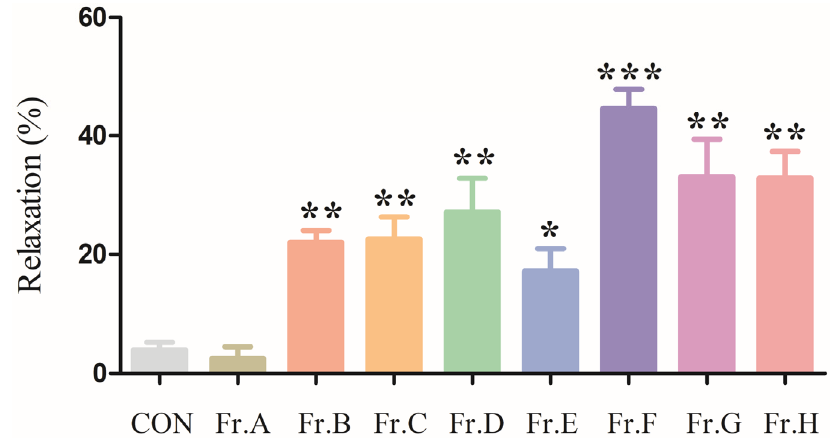
Figure 1. The vasorelaxant effect of fraction F (Fr. F) was stronger than those of the other major fractions obtained from the Ostericum citriodorum ethyl acetate extract (OCE). Endothelium-denuded aorta rings were pre-contracted with noradrenaline (NE) before the eight major fractions (Fr. A–H) (1000 μ g/mL) were added. Values are means ± standard error of the mean (SEM) ( n = 6). Note: * p < 0.05, ** p < 0.01 each fraction compared with control (CON, incubation the vascular rings with 0.2% DMSO) group using two-way ANOVA.